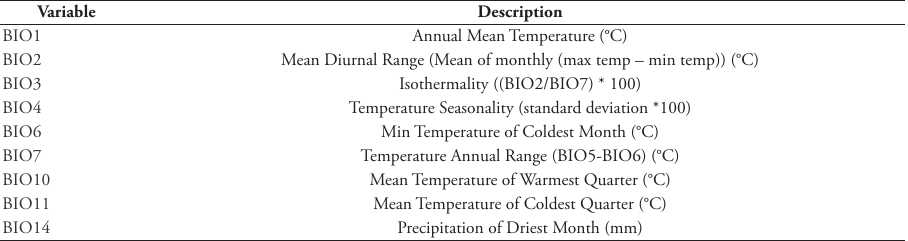
Table 1. WorldClim v.2 bioclimatic variables included in the model, and their descriptions.